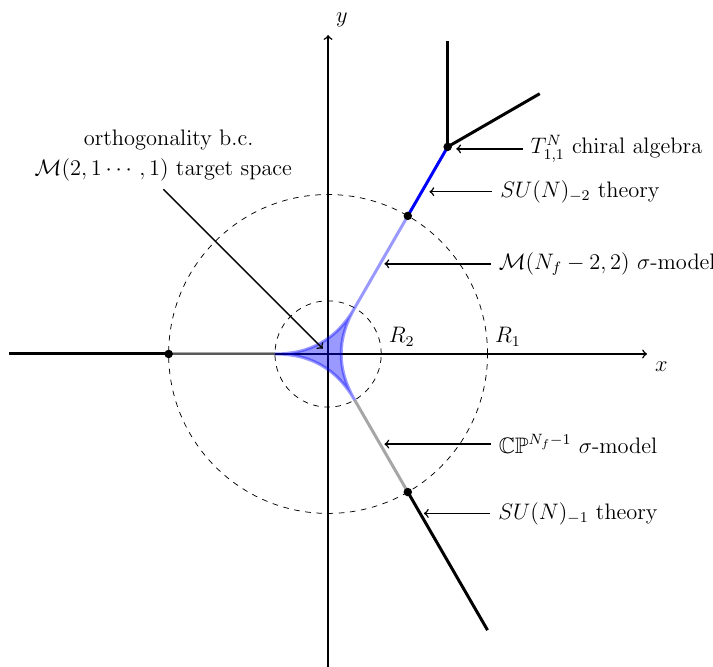
Figure 6: The dynamics in the interior for a mass profile m = (cid:34) re if ( α , r ) Λ 2 with (cid:34) (cid:28) 1 = 4. The centers of the interfaces follow the trajectories (colored in black when N f and blue) where f ( α , r ) = ( π + 2 π (cid:90) ) / N . Two interfaces (colored in black) can f merge into one interface (colored in blue) when their separation is less than 1 / Λ ∼ 1 / ( (cid:34) Λ ) . This leads to an interface junction that supports the outside the radius R 1 chiral algebra T N defined in (6.1). The theories on the interfaces undergo a tran- 1,1 sition from Chern-Simons theories to sigma models with appropriate Wess-Zumino terms at radius R . It leads to chiral modes localized at the transition interfaces. The 1 ∼ 1 / ( (cid:34) 1 / 3 Λ ) at the origin. On the interface junc- interfaces form a junction of size R 2 tion, one should impose an orthogonality boundary condition that reduces the target ( 2,1, ··· ,1 ) . The flag sigma model space on the junction to the flag manifold M